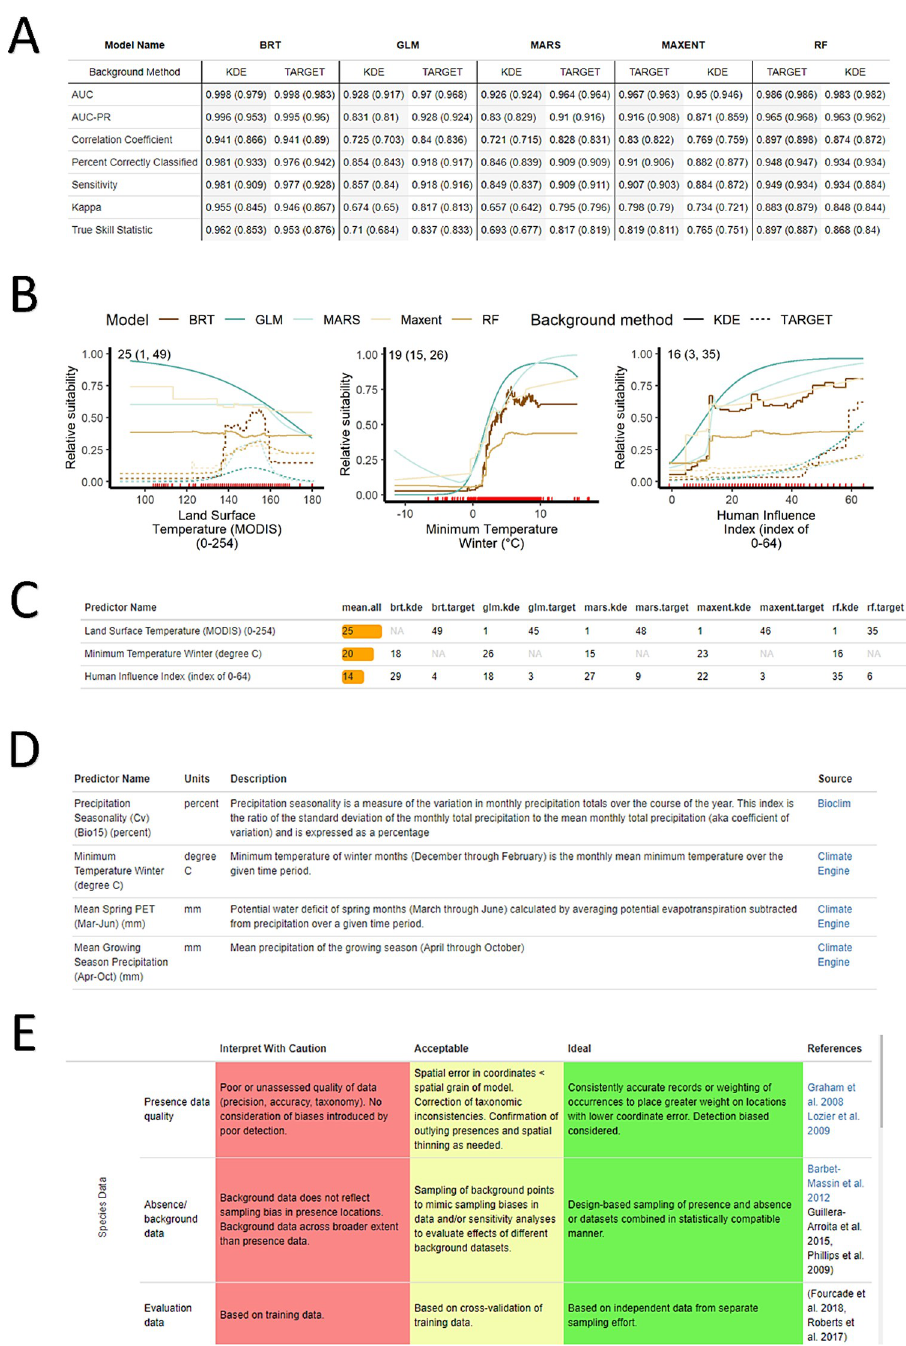
Fig 3. Example content clipped from the “Model Details” tab. Each chart’s symbology also indicates model type: boosted regression trees (BRT), generalized linear model (GLM), multiadaptive regression splines (MARS), maximum entropy (MAXENT), random forest (RF), and background point generation method (target or kernel density estimate [KDE]). A) Evaluation metrics; in each column, the first number is the value with full model training data and the second, in parentheses, is the mean value from 10-fold cross-validation splits. B) Response curve images representing relative habitat suitability across environmental predictor values. Numbers in the upper left corner within each plot indicate mean, low, and high variable importance values reading from left to right. C) A tabular view of variable importance. Each row displays predictor names. D) Predictor descriptions and hyperlinks to variable sources, and E) the model credibility table based on the model assessment rubric from Tables 1a-c in [8]. Though it is a static template currently based on the overall modeling framework, the future version of this table will update its evaluative criteria relative to models for the selected